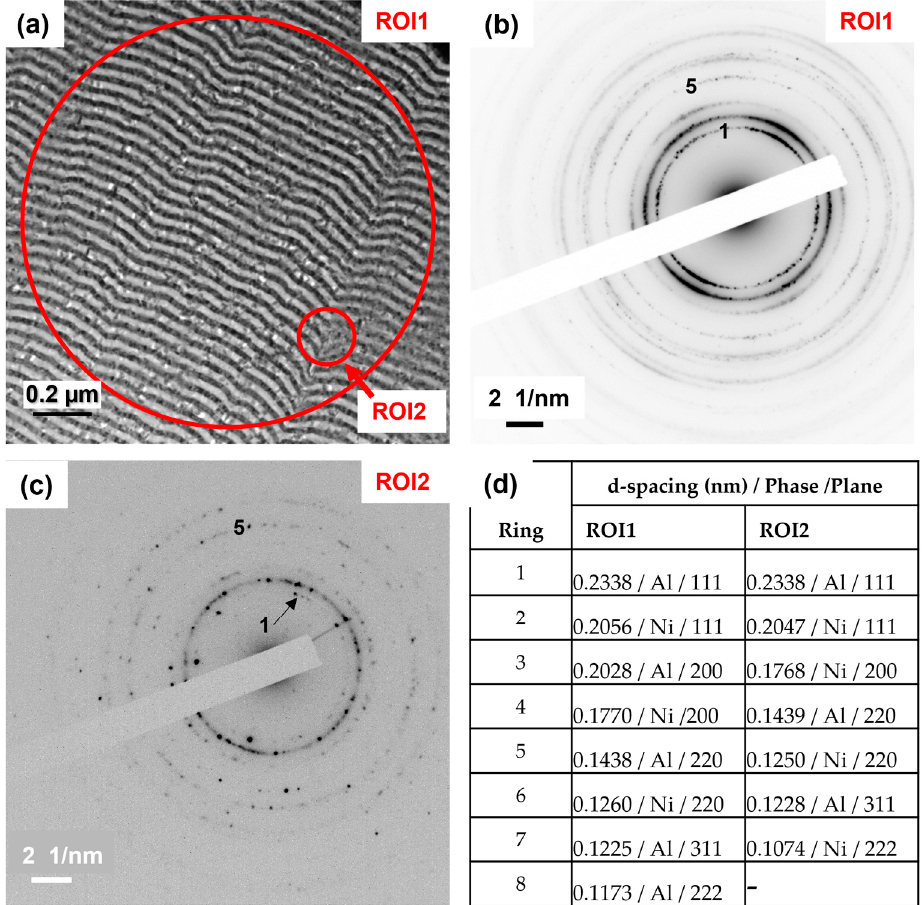
Figure 5. ( a ) TEM image of the unstructured Ni/Al multilayer; ( b ) SAD image of a larger area indicated as ROI1 in ( a ); ( c ) SAD image of a 180 nm wide, slightly fuzzy area indicated as ROI2 in ( a ); ( d ) list of diffraction rings, measured d-spacings, and assigned phases and lattice planes. All diffraction rings can be assigned to the elemental phases Ni and Al. Panels ( b , c ) were inverted and gamma was reduced in ( b ) for be tt er visibility. Di ff raction rings 1 and 5 are labeled for reader convenience.